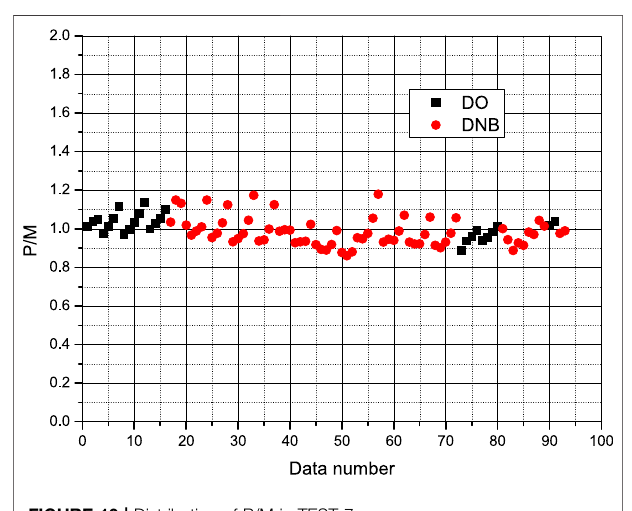
FIGURE 12 | Predicted and measured CHF locations in TEST